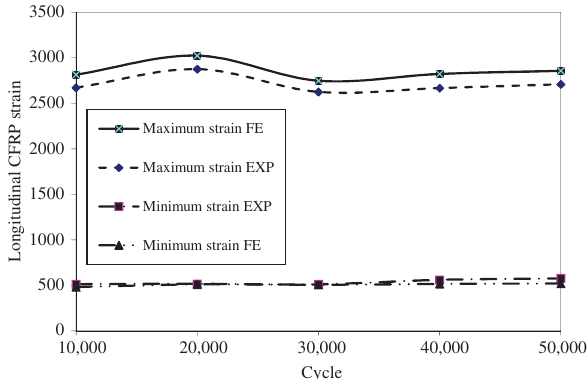
Figure 16: Comparison of monotonic and post-fatigue monotonic load-deflection curves of RC specimens obtained by FE and experi- mental analyses.